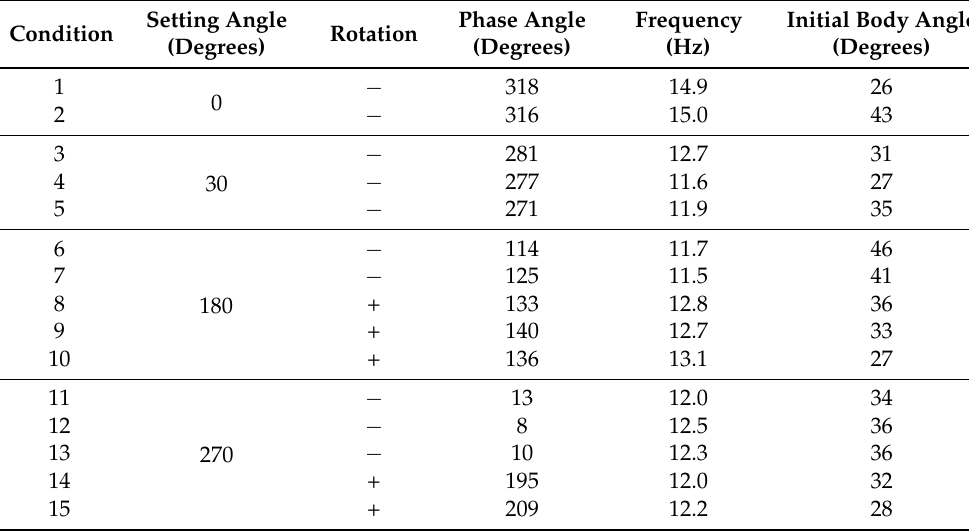
Figure 9. Flight trajectories and body angles in free-flight for the four modes. The phase angles in the four modes are 114° ( a ), 195° ( b ), 271° ( c ), and 10° ( d ), which correspond to conditions 6, 14, 5, and 13 in Table 3, respectively. Each angle corresponds to forewing-lead, counterstroke, hindwing-lead, and in-phase modes, respectively. The dot and line represent the forewing pivot and the line between two pivots, respectively. The data were plotted every 10 ms. Some points are missing because of incomplete body point data. Table 3. Flapping performance in each angle setting during free-flight.